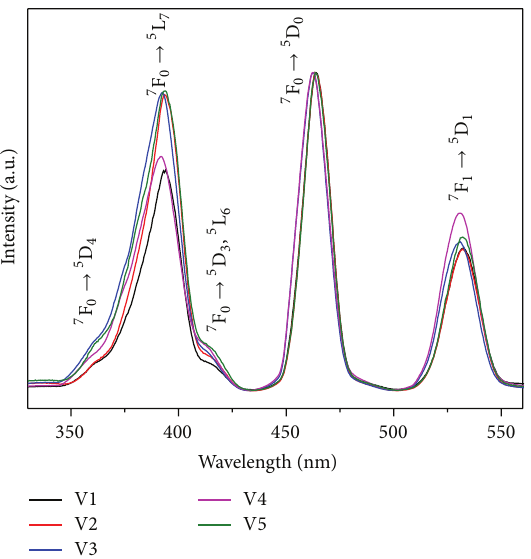
Figure 5: Excitation spectra of the glasses monitored at 613 nm.